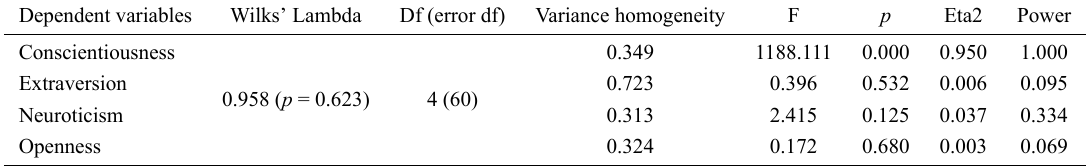
Table 6. Multivariate analysis of variance results for personality characteristics by injury experience.